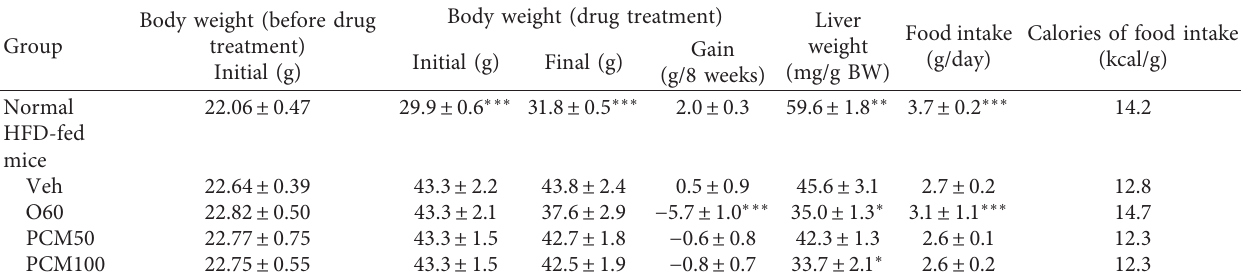
Table 1: The effect of PCM on body weight, liver weight, visceral fat weight, and food